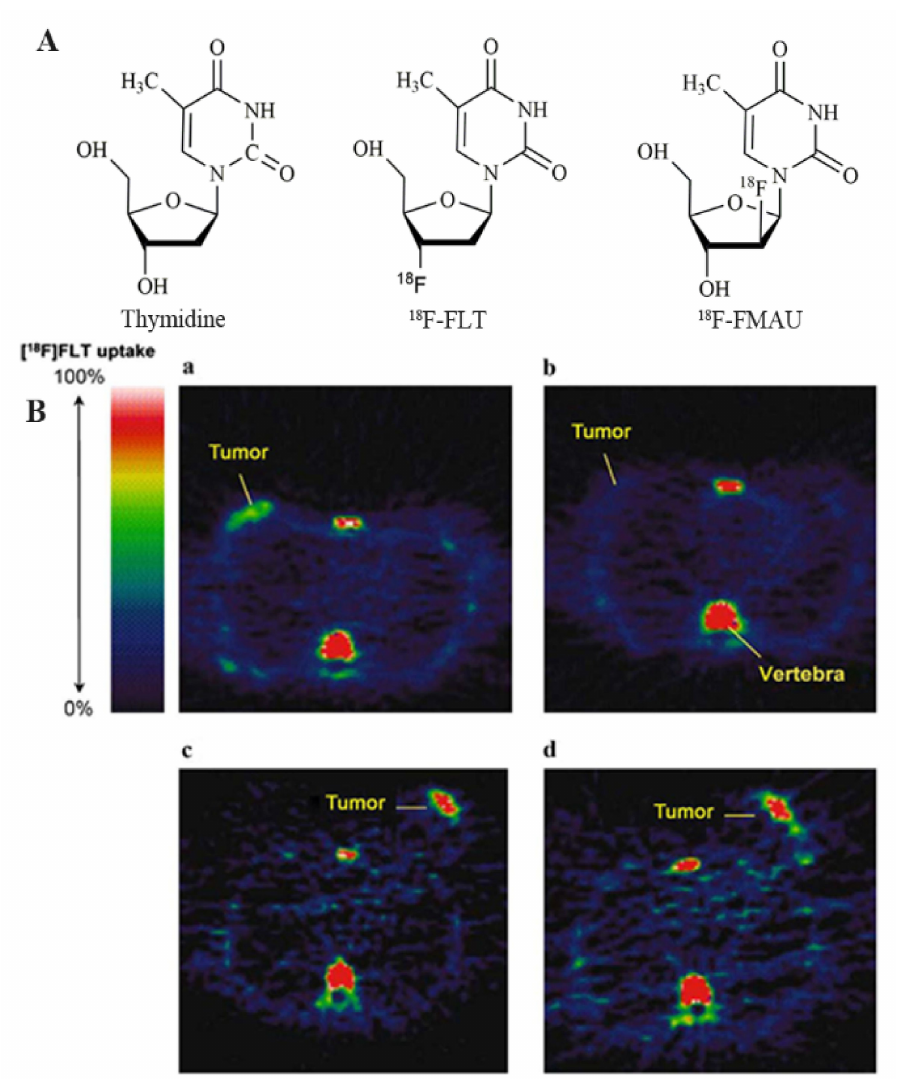
Figure 3. Chemical structure of ( A ) thymidine, 18 F-FLT, and 18 F-FMAU; ( B ) 18 F-FLT PET imaging of a patient with grade II breast cancer 1 week after administration of combination chemotherapy. ( a ) pretreatment and ( b ) posttreatment of a patient with lobular breast cancer who responded to treatment. ( c ) pretreatment and ( d ) posttreatment of a patient with invasive ductal breast cancer who did not respond to treatment